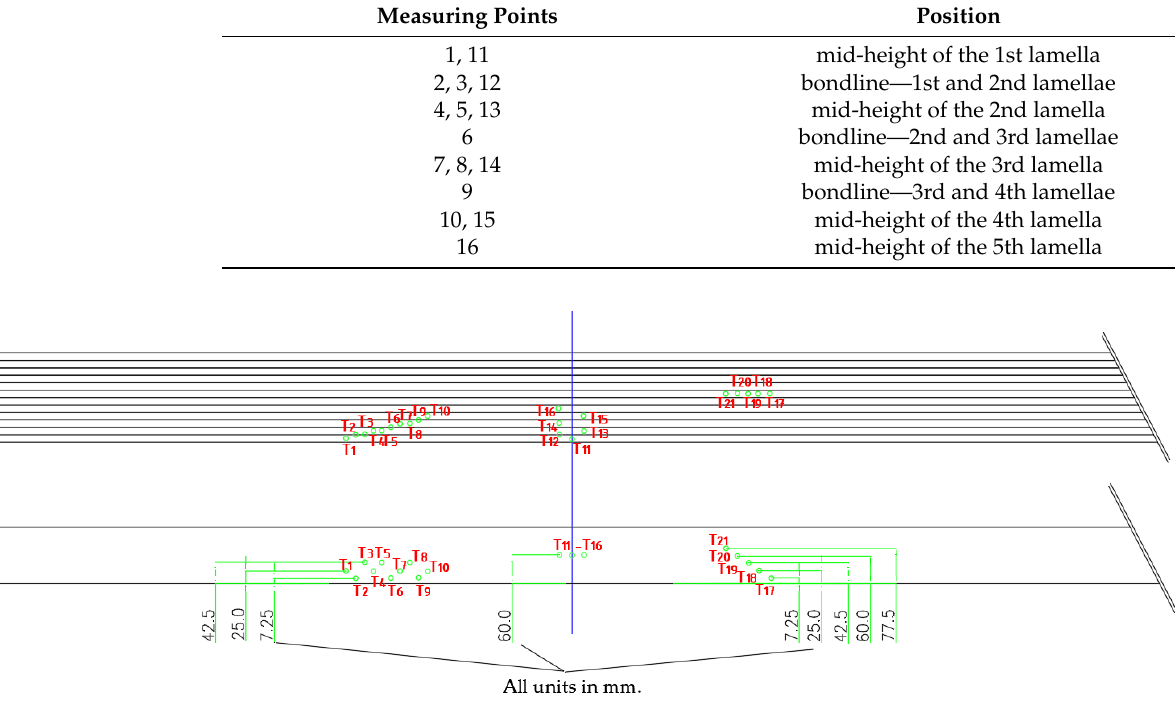
Figure 12. Thermocouple layout. Table 4. Thermocouple installation depth.